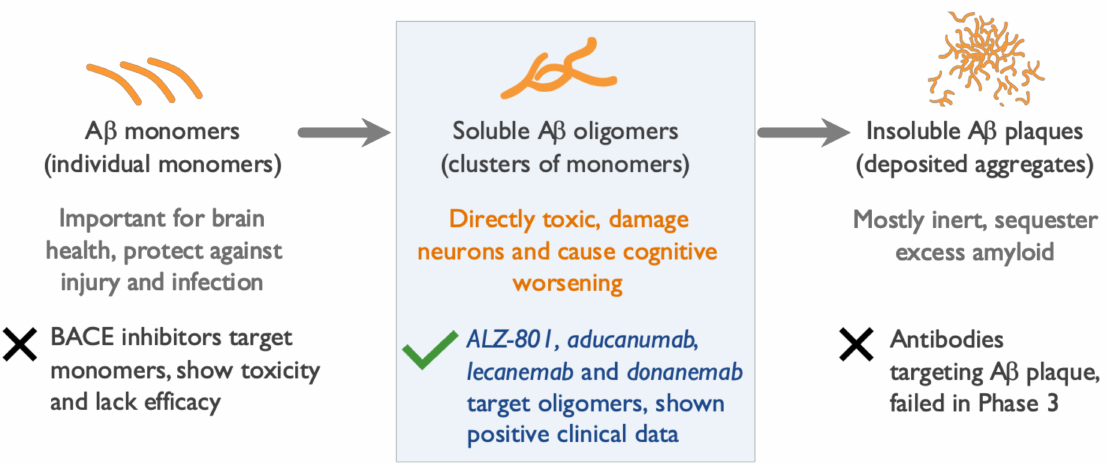
Figure 5. Only agents that target amyloid oligomers show efficacy in Alzheimer’s disease (AD) trials. Among dozens of failures, only four anti-amyloid agents showed positive clinical results in late-stage clinical trials. All four of these agents either selectively inhibit formation of amyloid oligomers or remove oligomers from the brain: the oral tablet ALZ-801 and the intravenously (IV) infused anti-amyloid antibodies aducanumab, donanemab, and lecanemab. Agents that remove or inhibit formation of beta amyloid (A β ) monomers or clear amyloid plaques failed to show efficacy in AD trials